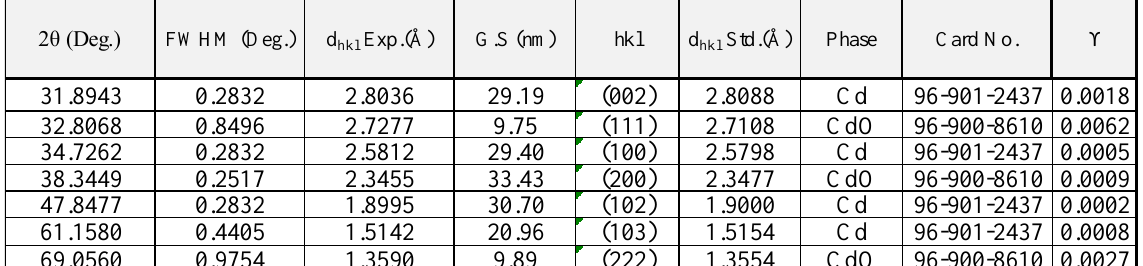
, microstrains ϒ for CdO, Cd films hkl